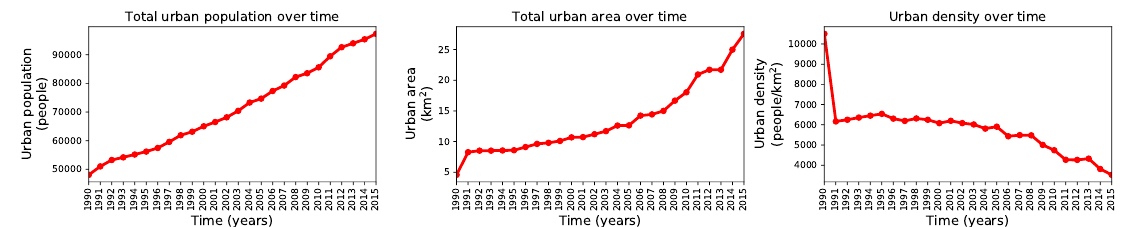
Figure 20. Diagnostic graphs of the geographic area of interest masked by the administrative division of Rionegro. ( Left ) total urban population. ( Center ) total urban area. ( Right ) urban density. Valledupar Kernel density estimation of MSE for the best performing models from the autotuning (Number of observations = 5) BayesianRidge. Kernel = gaussian. Bandwidth = 1.58e-03. LinearRegression. Kernel = gaussian. Bandwidth = 1.57e-03.